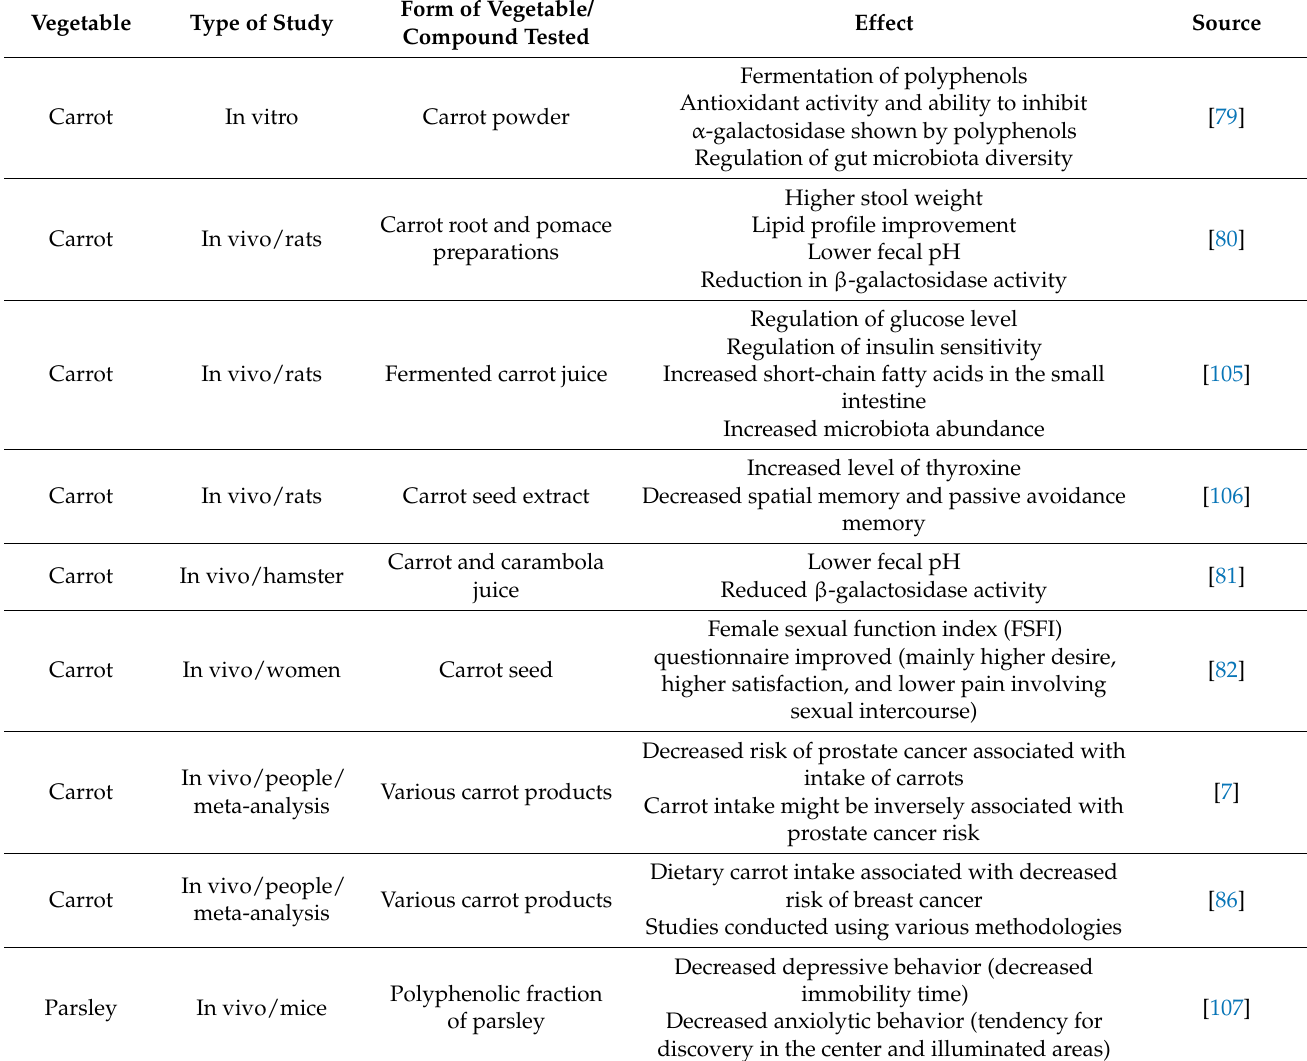
Table 4. Influence of root vegetables from the botanical family Apiaceae on